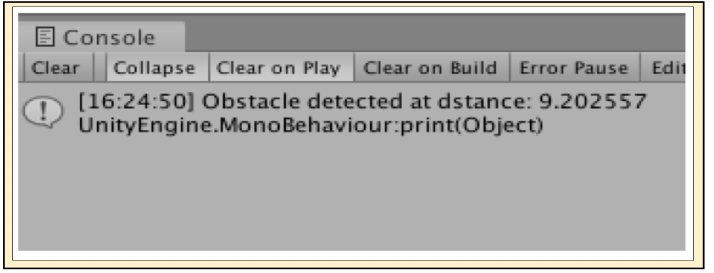
Figure 24. Sample notification assistance from the simulator (obstacle detected).